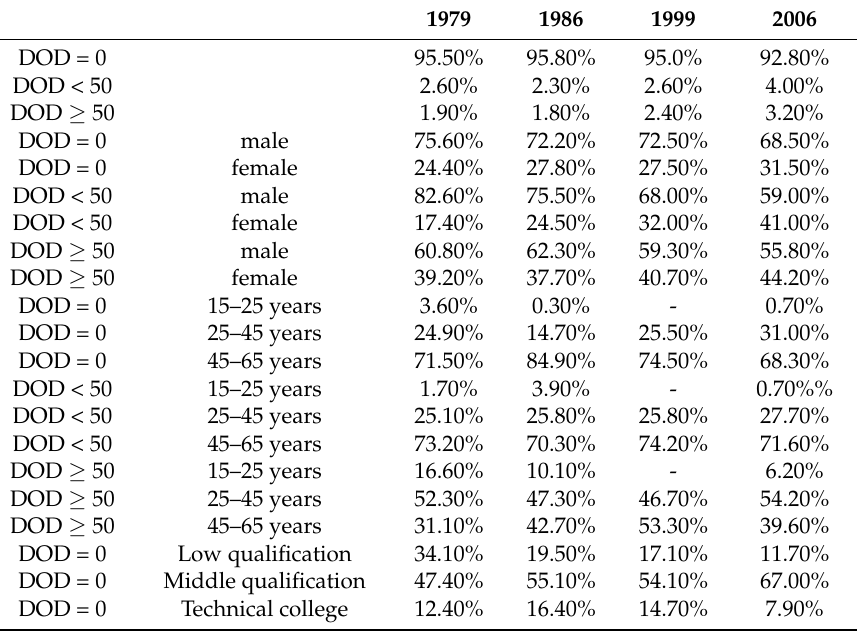
Table A1. Descriptive statistics of sociodemographic variables by degree of